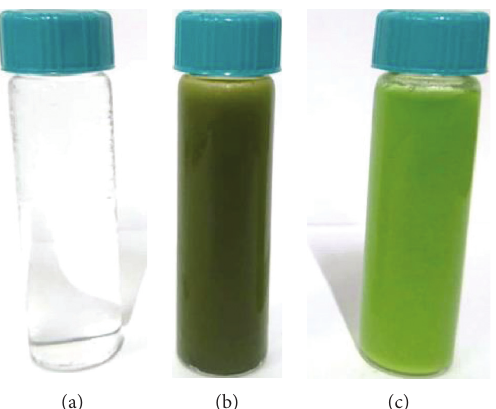
Figure 1: Colloidal solution of phytonanoparticles from the aqueous extract of Moringa oleifera : (a) ZnSO extract, and (c) ZnO phytonanoparticles after 12 hours of incubation at 60 ° C.